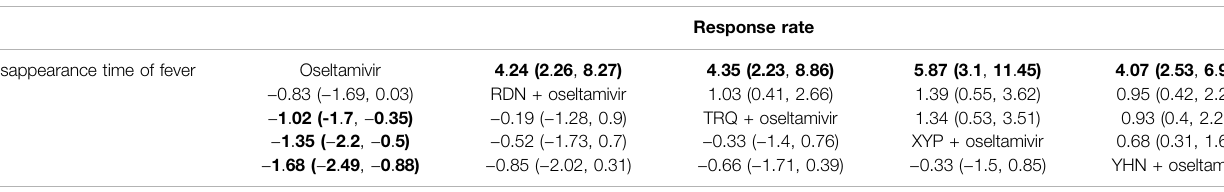
TABLE 1 | League table of response rate and disappearance time of fever.